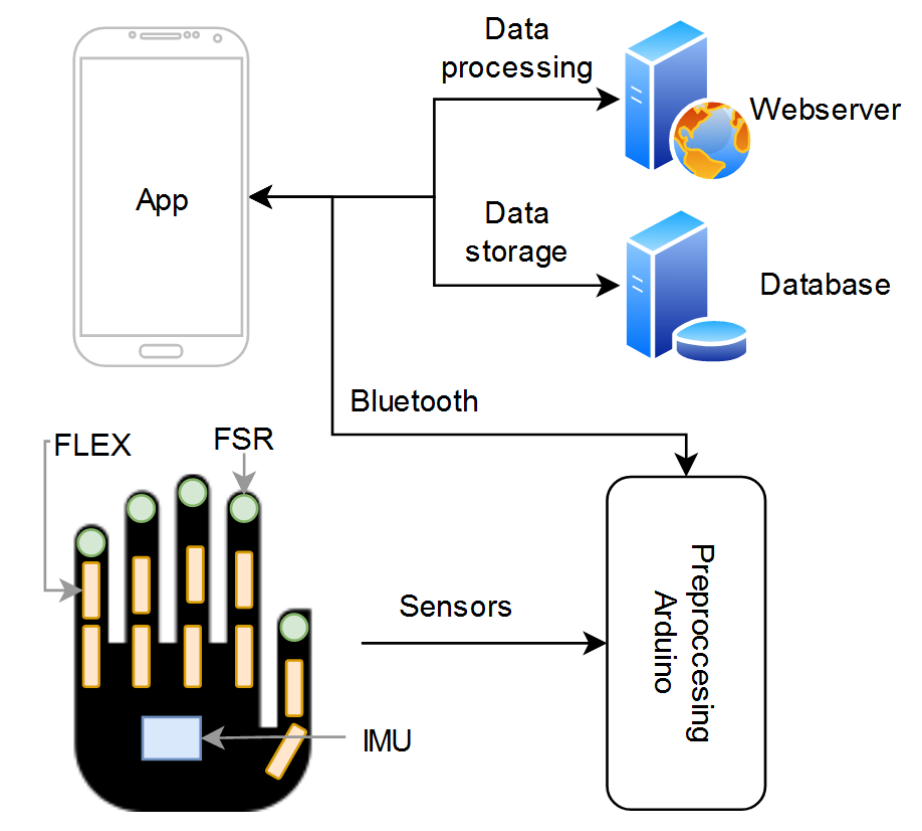
Figure 2. Integrated system.